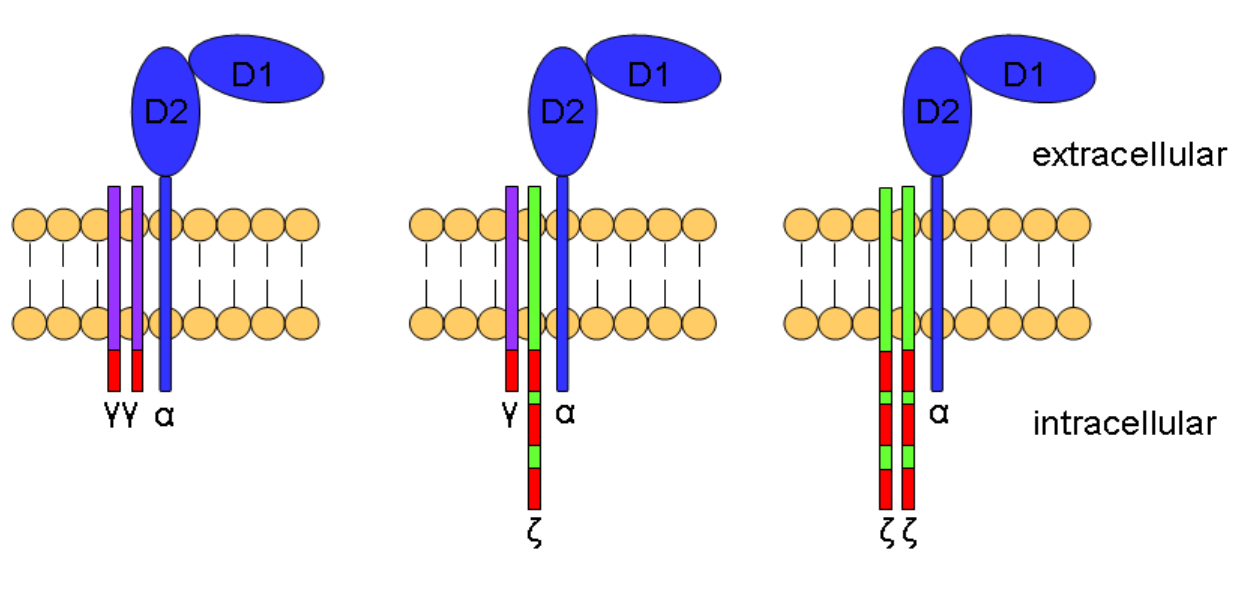
Figure 1. Structure of CD16. A schematic drawing of CD16 showing the two Ig-like extracellular subunits, D1 and D2, and the α -chain (blue) in complex with Fc ε RI- γ (purple) or CD3 ζ (green) chains. Immunoreceptor tyrosine-based activation motifs (ITAMs) motifs are shown in